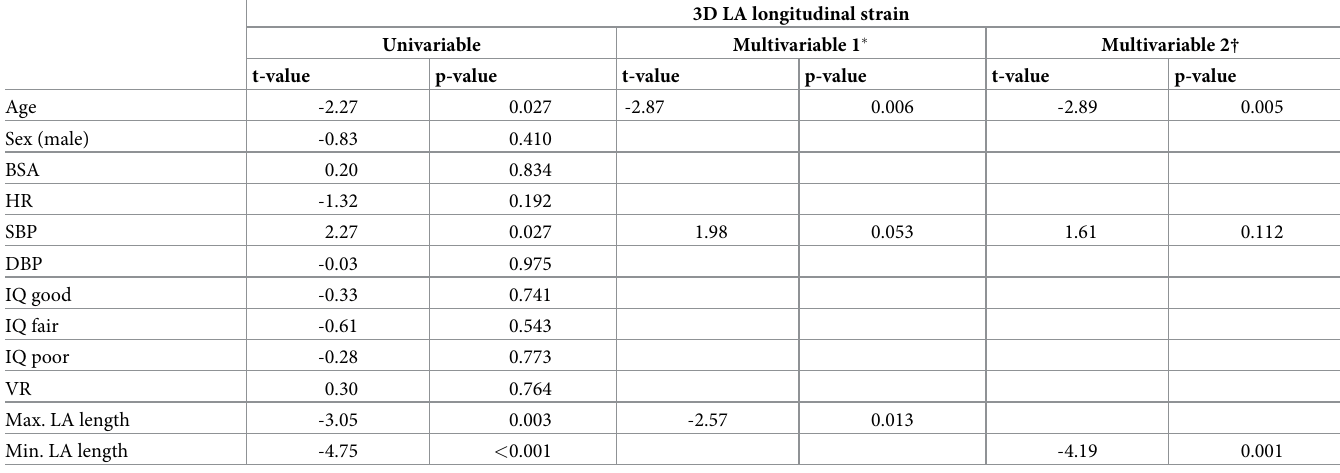
Table 6. Univariate and multivariate linear regression analysis for the association of left atrial longitudinal strain assessed with 3D echocardiography in patients having cardiovascular